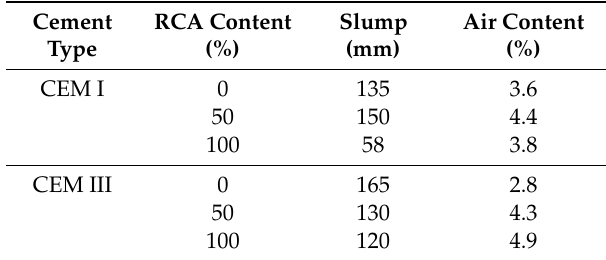
Table 5. Slump and air content of RAC